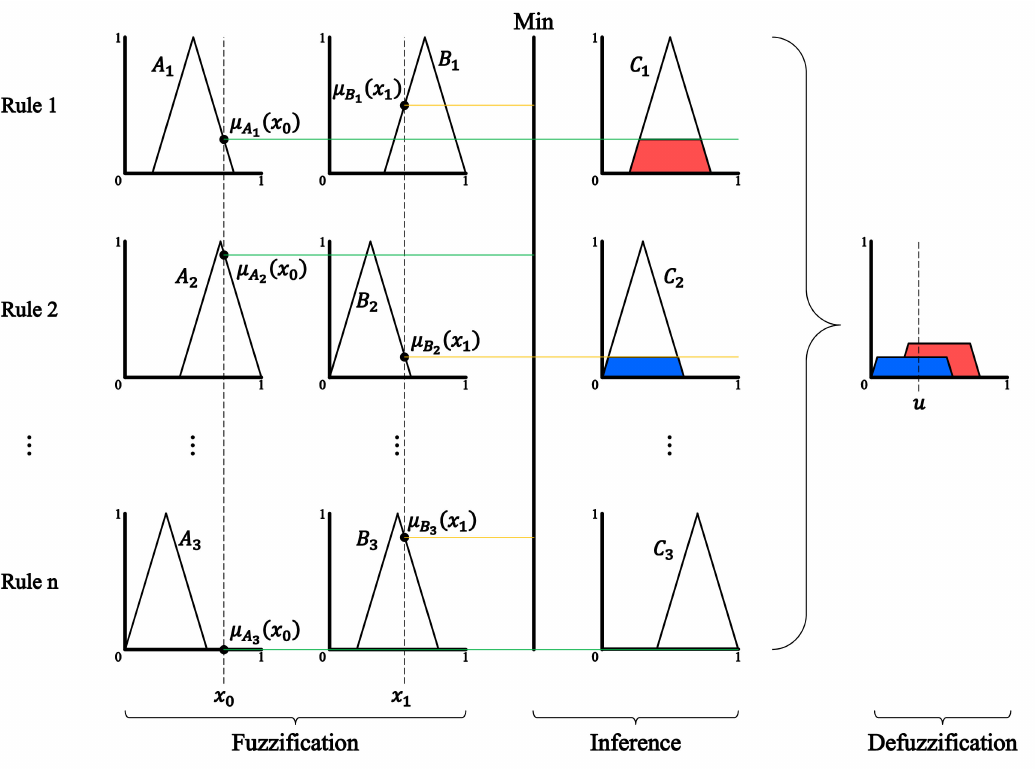
Figure 12. Fuzzy logic controller.